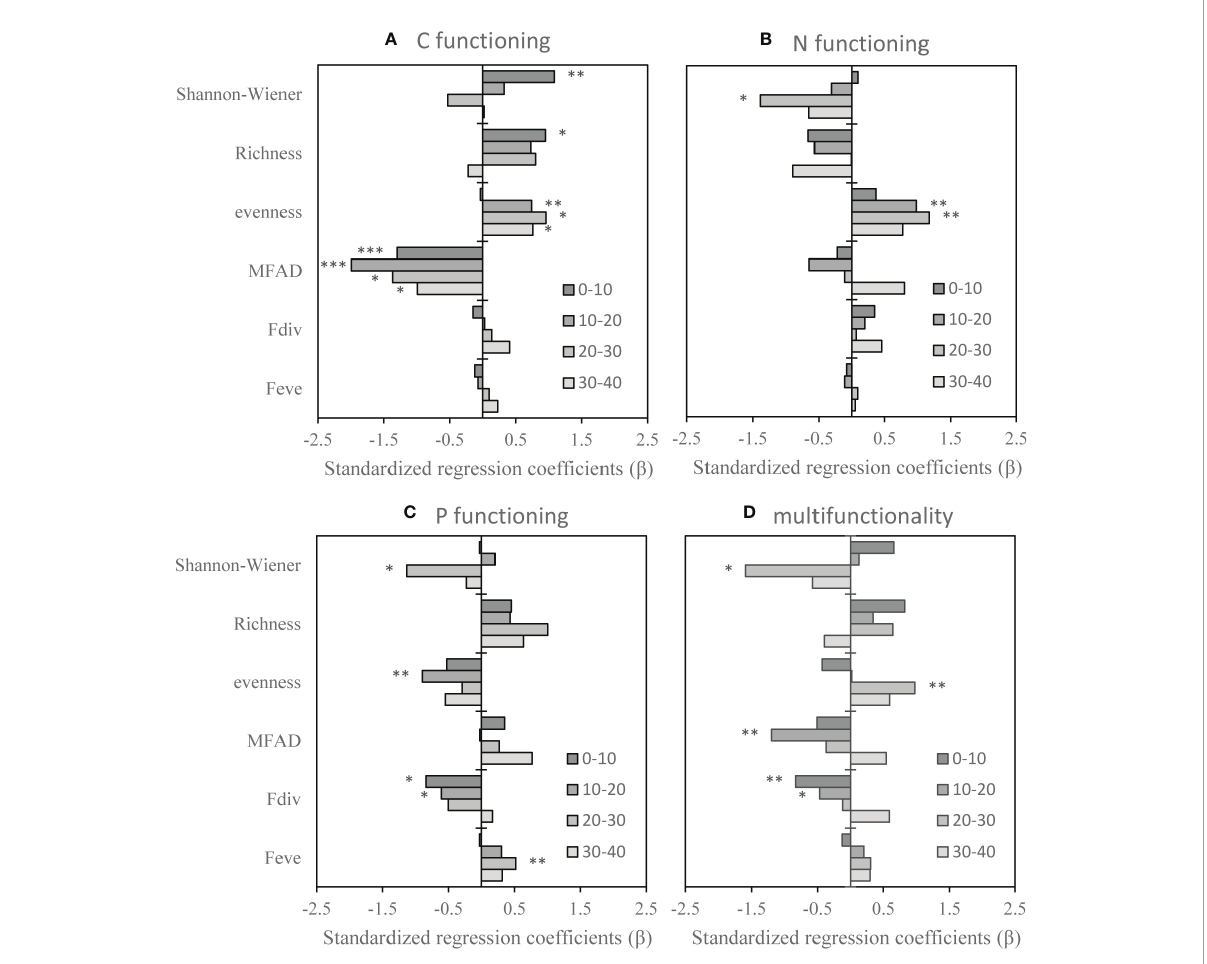
FIGURE 3 Standardized regression coef fi cients ( b ) obtained from multiple linear mixed effect models (LMMs) for each soil functioning in four depths. (A) Carbon functioning, (B) nitrogen functioning, (C) phosphorus functioning, (D) multifunctionality. MFAD, modi fi ed functional attribute diversity; Fdiv, functional divergence; Feve, functional evenness. ***, **, and * stand for P < 0.001, P < 0.01, and P < 0.05,